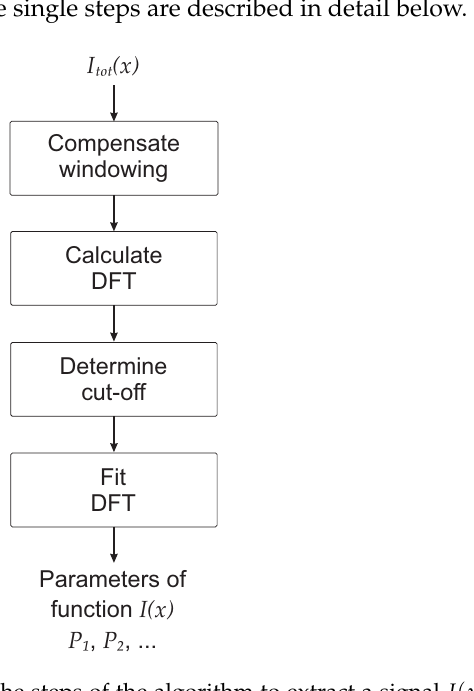
Figure 1. Schematic flow diagram of the steps of the algorithm to extract a signal I ( x ) from a total signal I tot ( x )